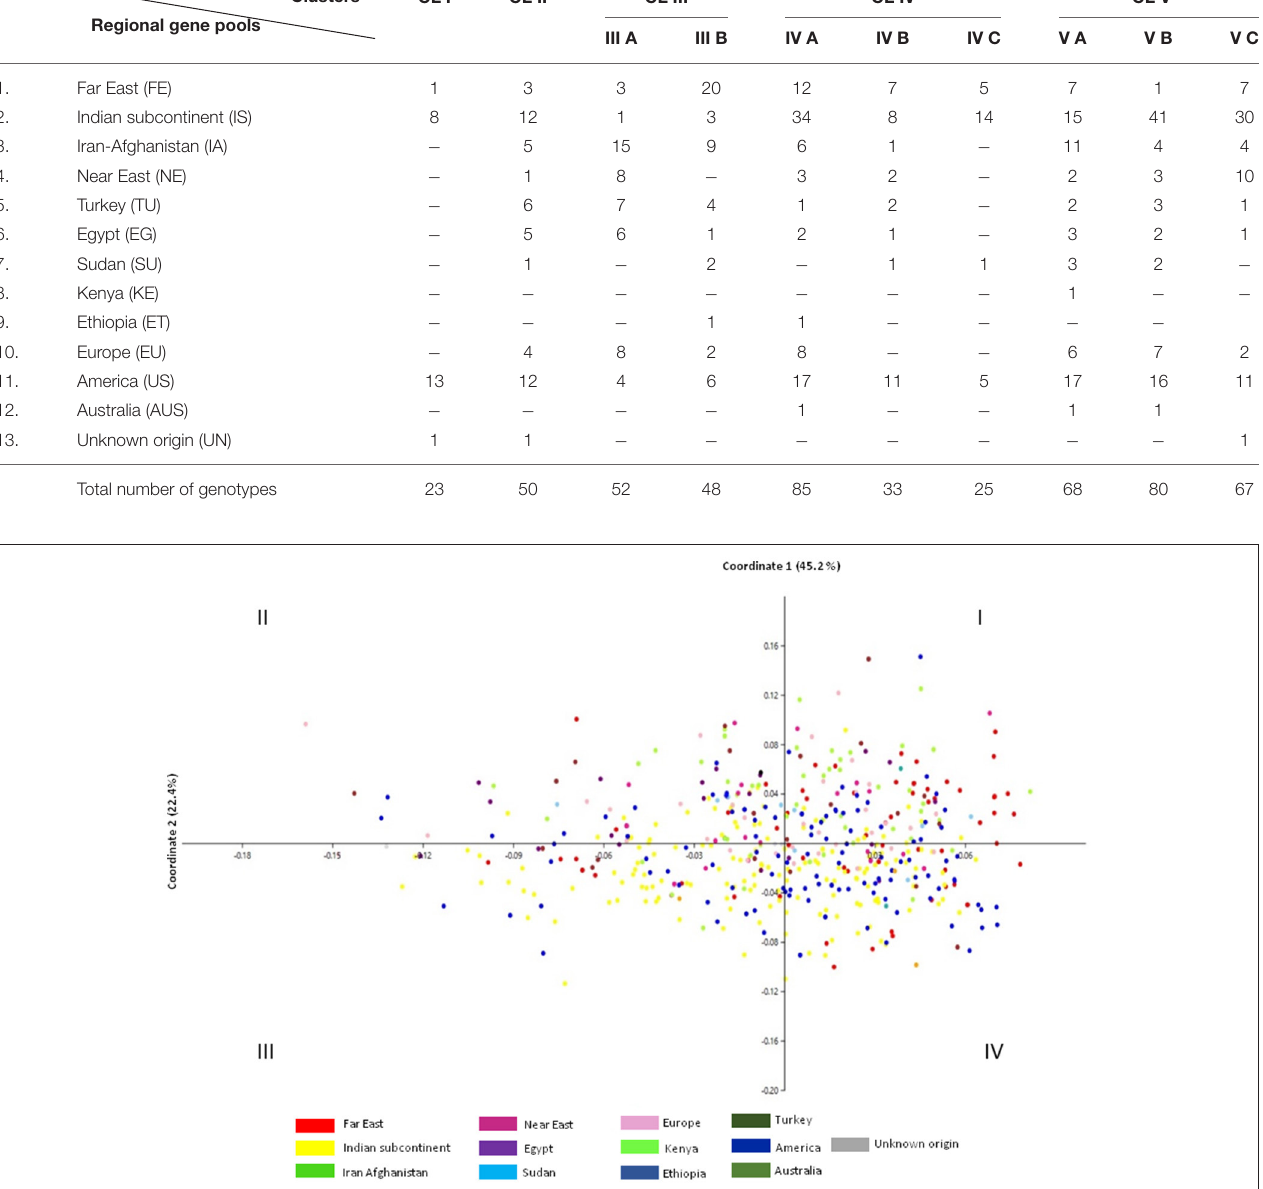
FIGURE 2 | Principal coordinate analysis of 531 safflower accessions based on Euclidean distance matrix using 12 morphological traits. Color codes correspond to region of origin.